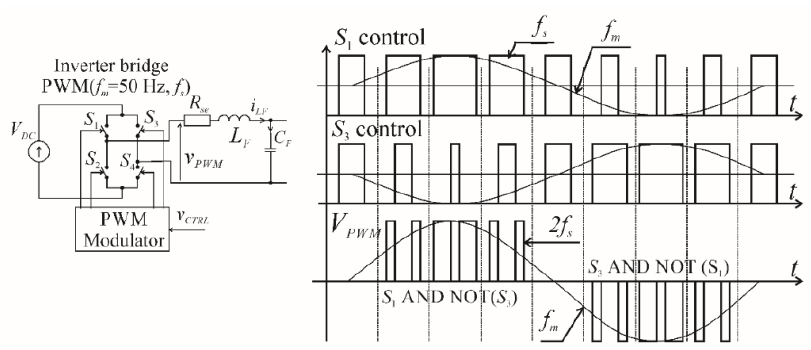
Figure 3. The advantages of this controller include the possibility of controlling output voltage when crossing zero, and an output switching frequency double that of the transistor switching frequency.